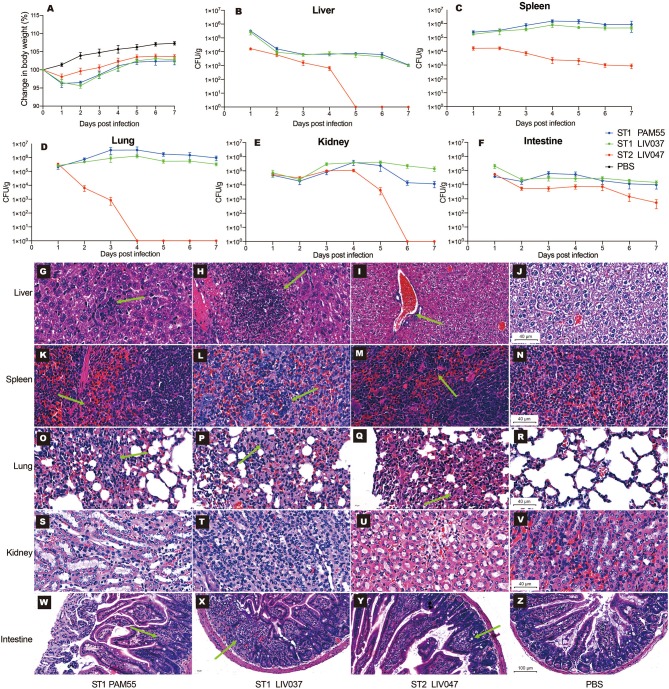
Virulence analysis of L. ivanovii subsp. ivanovii strains in mouse model. Change in body weight (A) and bacterial loads in the liver (B), spleen (C), lung (D), kidney (E), and intestine (F) were recorded for 7 days. Bars represent the mean of five replicates mean ± SD. Histopathologic analysis of organs in 4 dpi were shown in (G–Z). (G–V) were captured under the 40x microscope, and (W–Z) were captured under the 20x microscope. The green arrows denote the pathologic injuries such as neutrophil infiltration, hemorrhage, alveolar septum widened and granuloma.